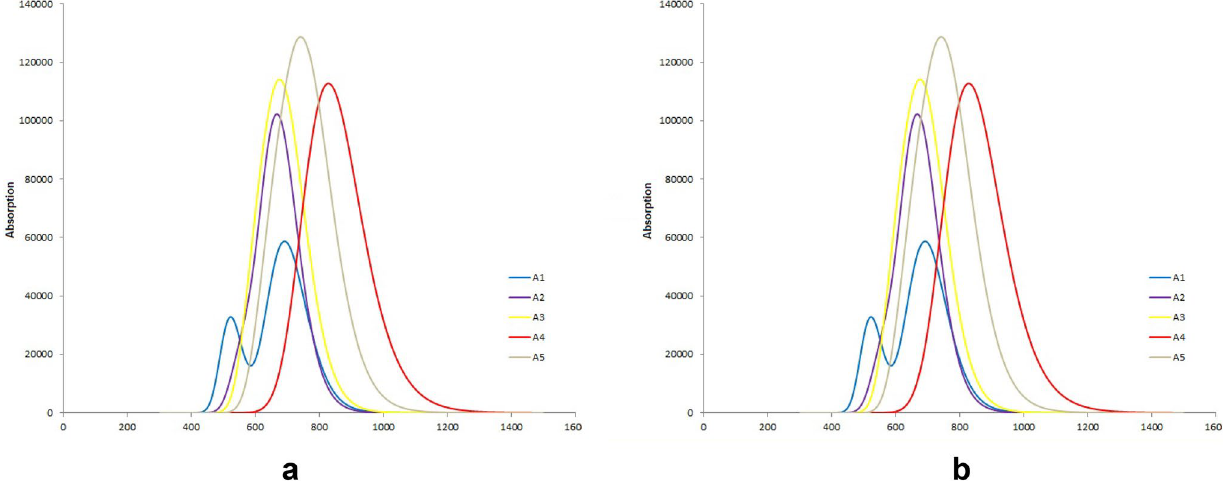
Figure 4. The UV absorptions of A1 – A5 at TD-DFT B3LYP 6-31 G(d,p): ( a ) in gas phase, ( b ) in CHCl 3 (IEFPCM